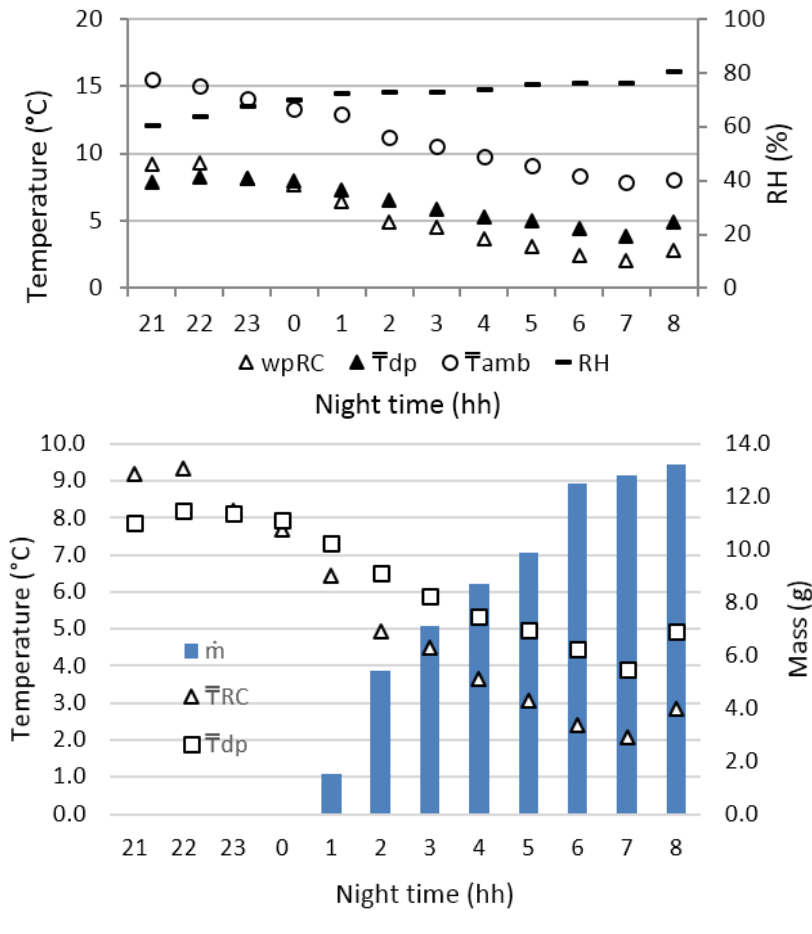
Figure 4. Hourly dew harvest and weather conditions during a representative night.